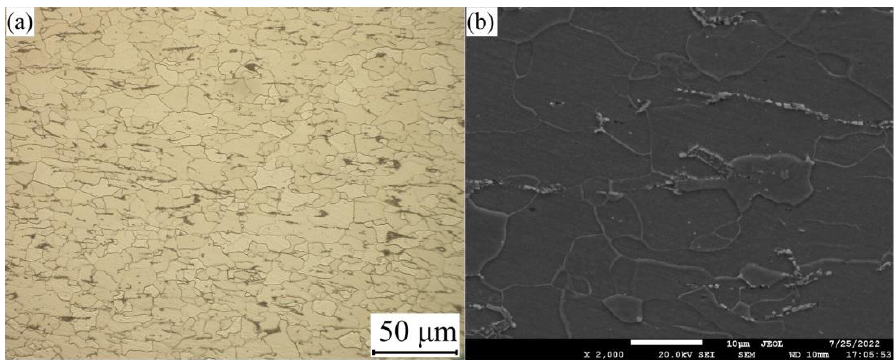
Figure 2. The microstructure of the BM: ( a ) OM; ( b ) SEM.